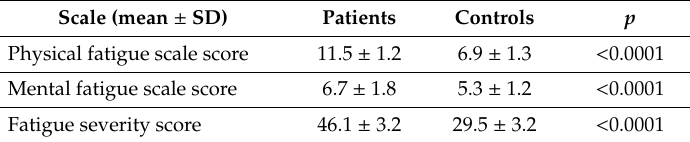
Table 3. Fatigue questionnaires data from subjects with and without